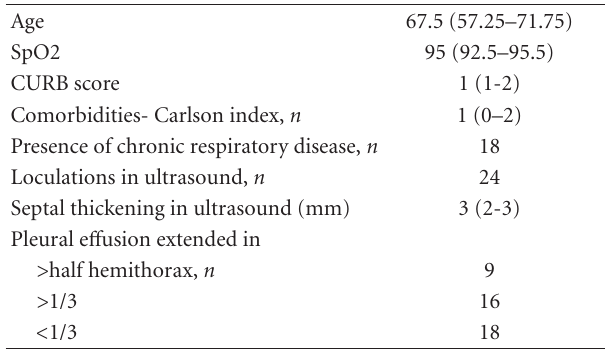
Table 1: Baseline characteristics of all 57